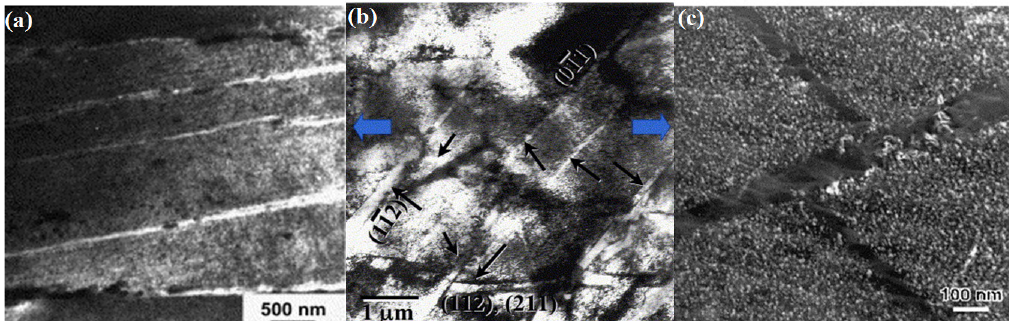
Figure 8. (color online) Observation of defect-free channels (or say dislocation channels) in irradiated metals after plastic deformation. ( a ) Zirconium alloys. (Reprinted with permission from [122]. Copyright 2004 by Elsevier.) ( b ) Iron irradiated at 0.4 dpa and 343 K. (Reprinted with permission from [10]. Copyright 2006 by Elsevier.) ( c ) Palladium single crystals irradiated with protons. (Reprinted with permission from [60]. Copyright 2000 by